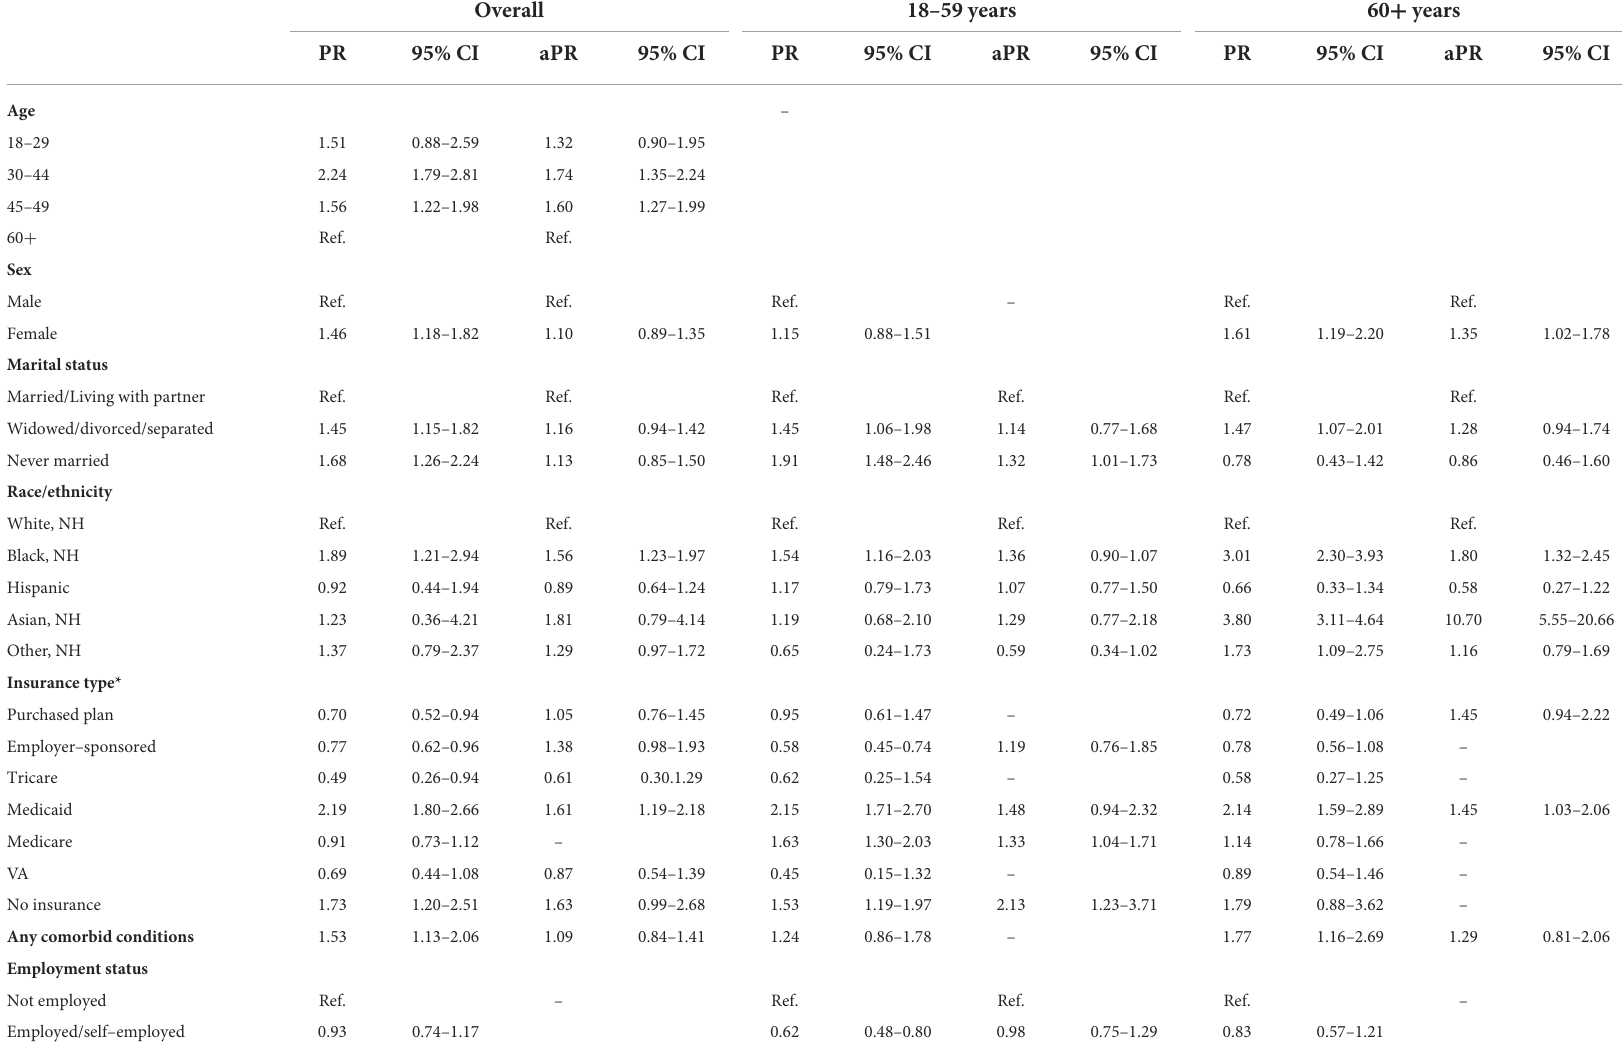
TABLE 3 Associated characteristics of financial hardship among cancer survivors in the COVID Impact Survey, a nationally representative survey of US ( n = 854) (April–June